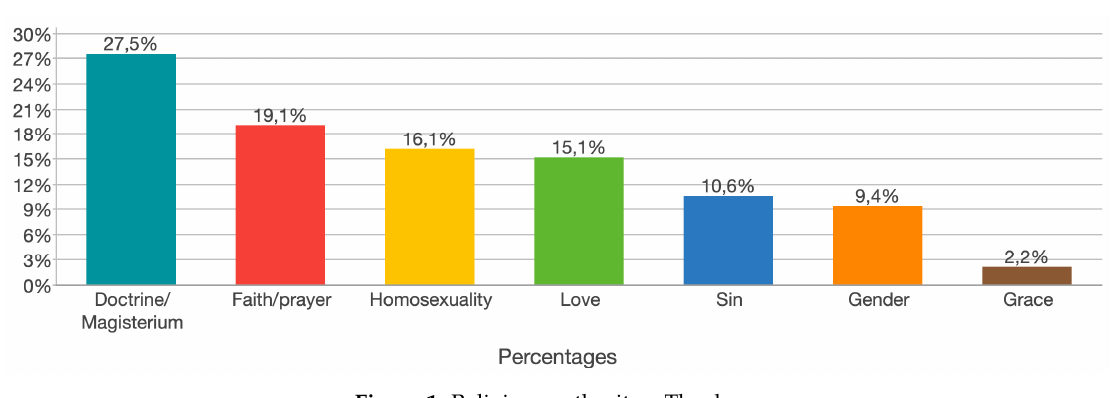
Figure 1. Religious authority—Theology.